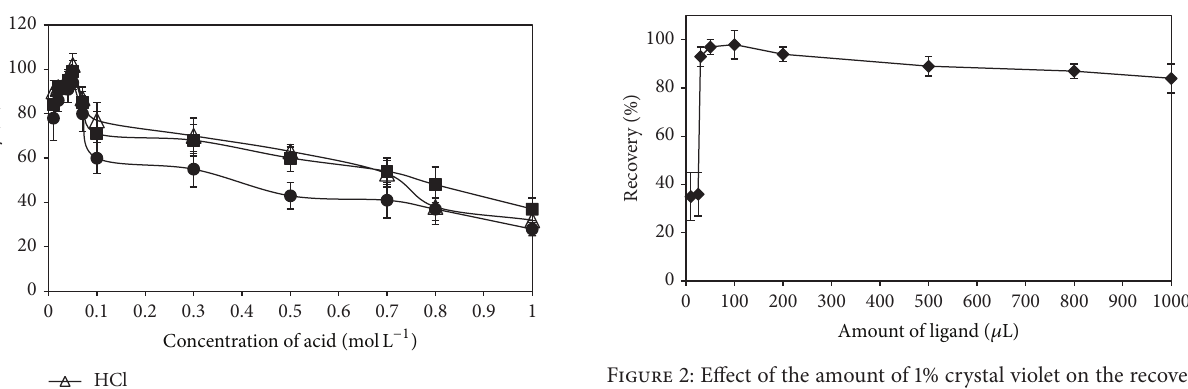
Figure 2: Effect of the amount of 1% crystal violet on the recovery of Bi(III)